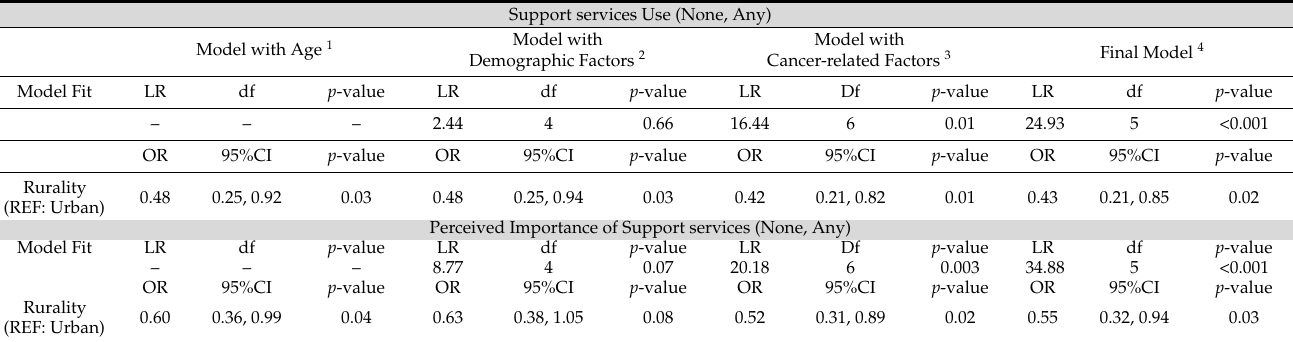
Table 3. Adjusted logistic regression models examining rurality and supportive service use and perceptions. Model